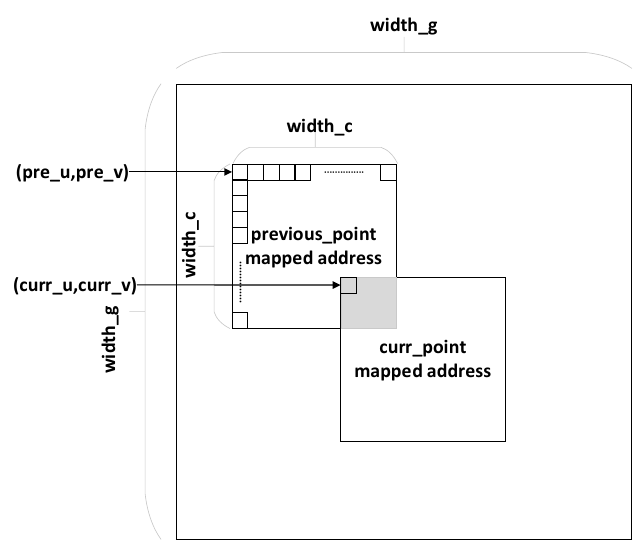
Figure 11. Grid data conflict condition.